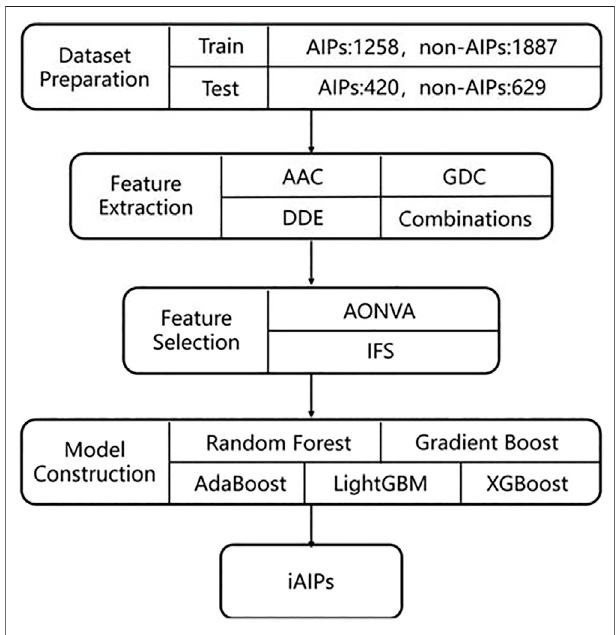
FIGURE 1 | The framework of